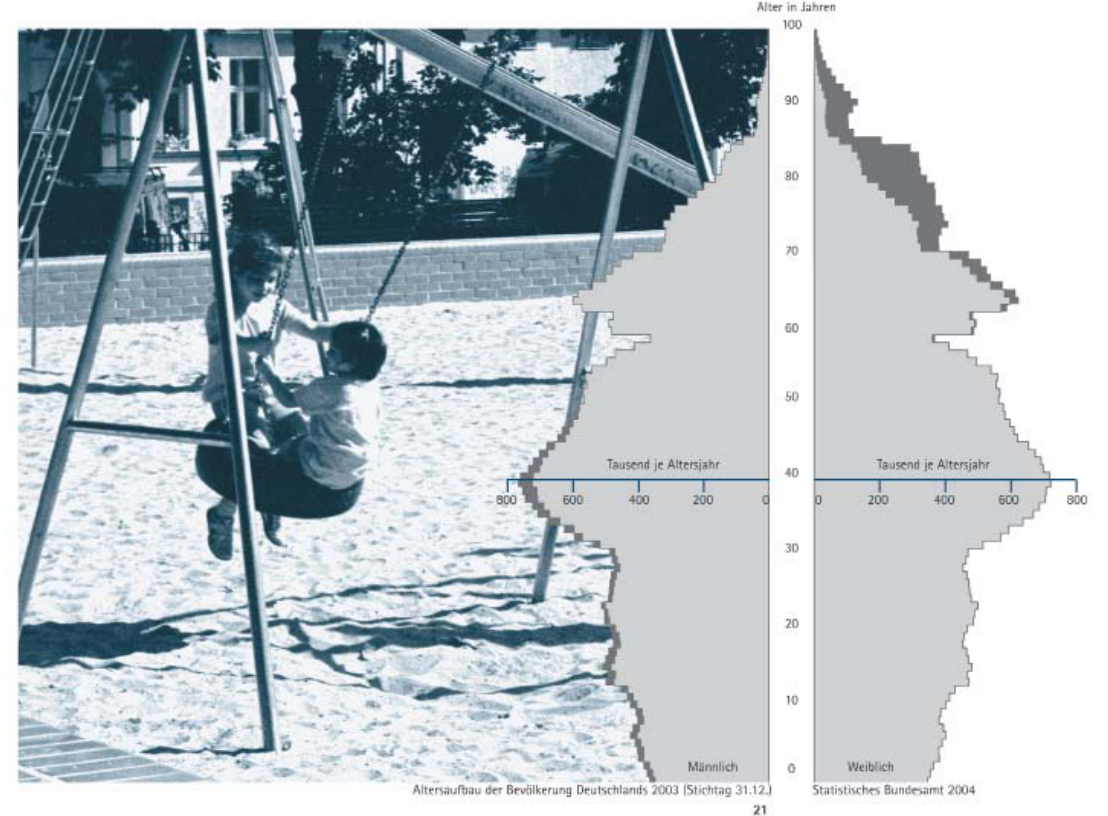
Figure 2. Collage “Demographic change” (Artner et al.